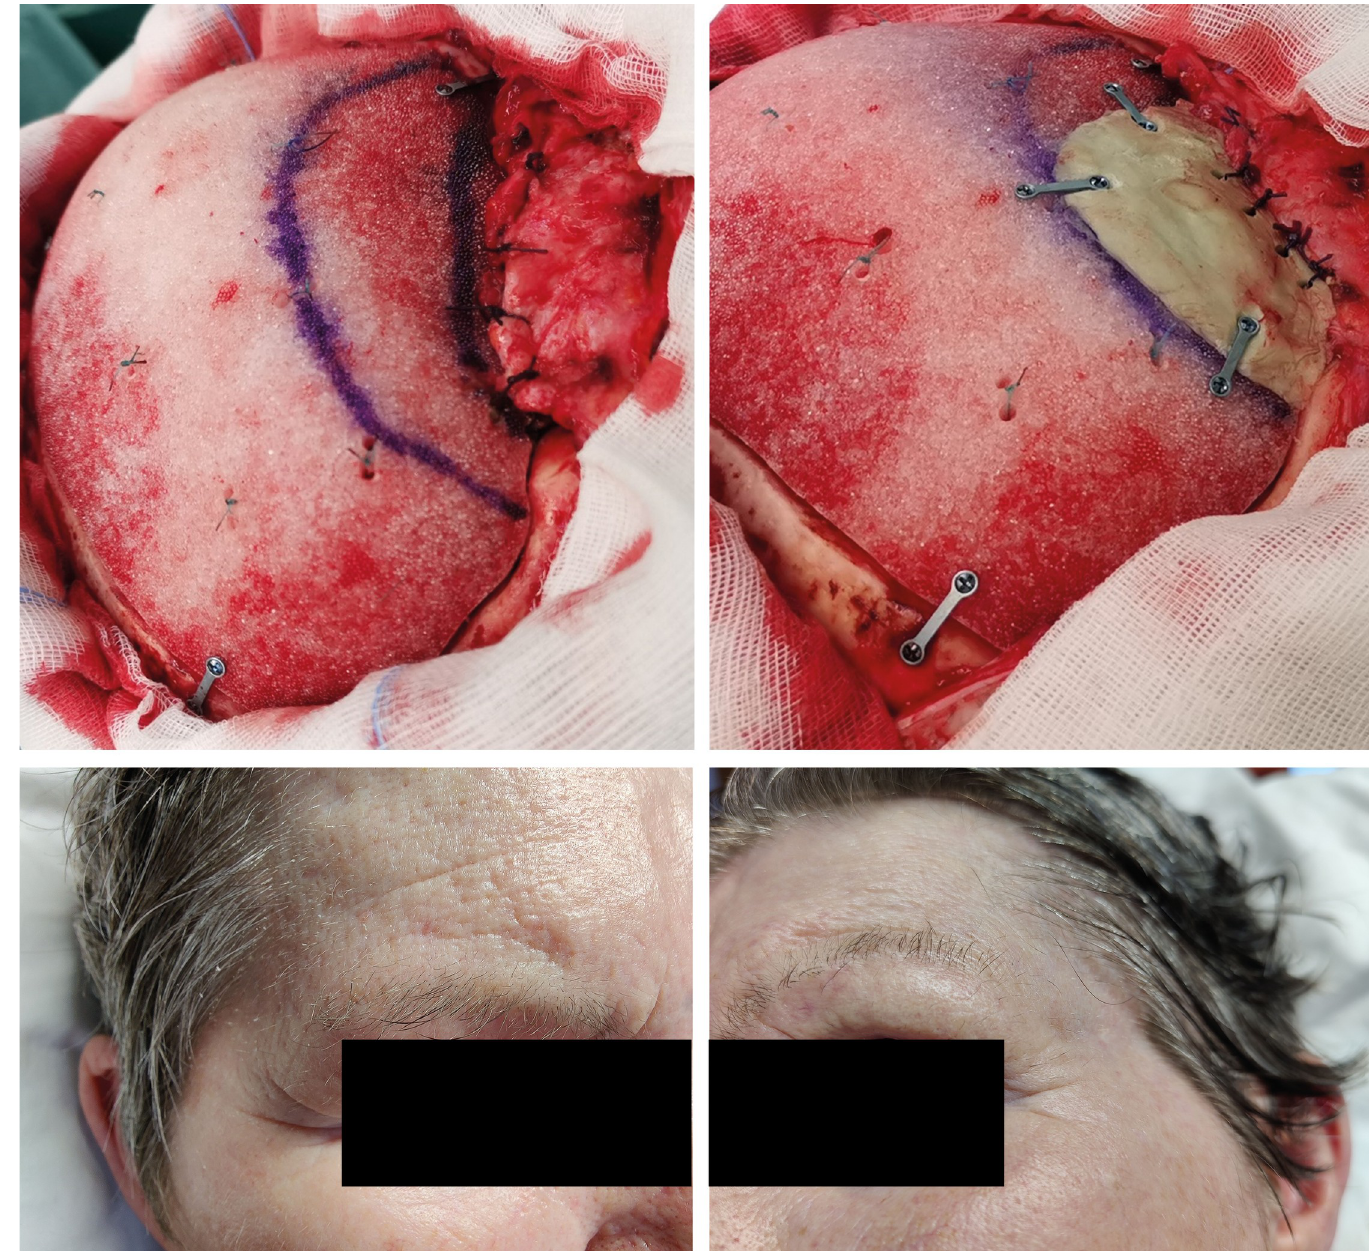
Fig 5. Photo illustration of a procedure of cranioplasty in which augmentation of the discussed region with PMMA was practised, and of the cosmetic result 1 year after surgery. Top left: Defect at the discussed region. Lower blue pen mark: Highest possible position of fixation of the restored temporal muscle. Higher blue pen mark in correspondence to the superior temporal line. Top right: Correction of the expected defect for the region of the frontozygomatic shadow with a PMMA bone cement substitute added to the CAD prosthesis. Bottom line: Photo of the patient 1 year after cranioplasty performed on the left patient side. Note that this patient naturally has a prominent zygoma on both sides, but that there is a good cosmetic result with a symmetric frontozygomtic shadow. (publication with kind authorisation of the patient/ next of